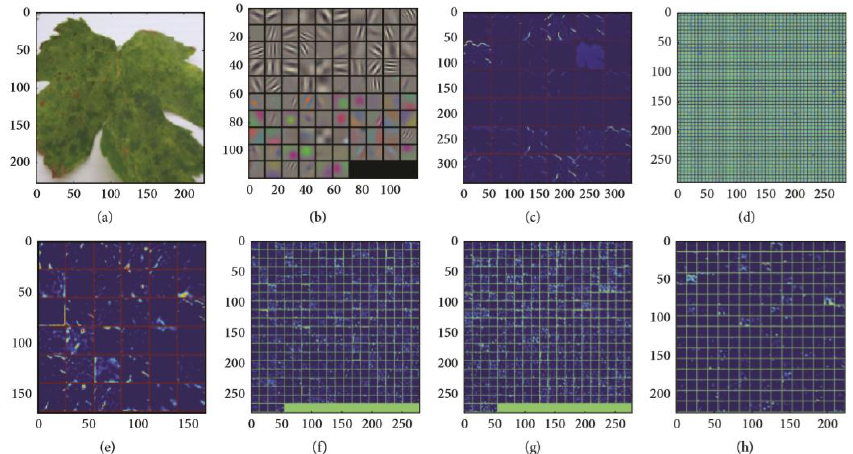
Figure 4. Feature maps after the application of convolution to an image: ( a ) real image, ( b ) first convolutional layer filter, ( c ) rectified output from first layer, ( d ) second convolutional layer filter, ( e ) output from second layer, ( f ) output of third layer, ( g ) output of fourth layer, ( h ) output of fifth layer [27].